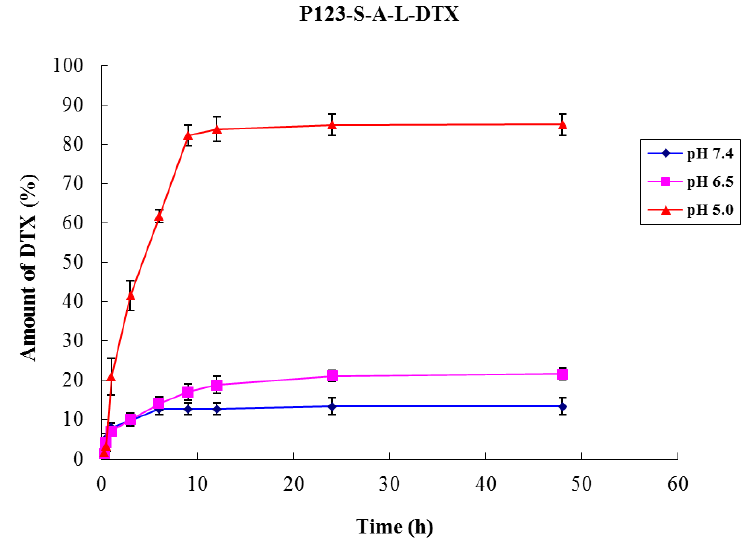
Figure 7. pH-dependent release of DTX from the P123-DTX conjugate micelles. Data are expressed as means ± SD ( n =